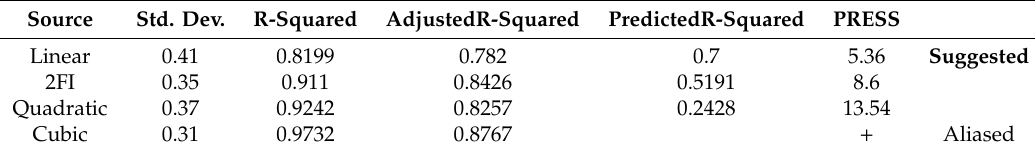
Table 6. Model summary statistic for